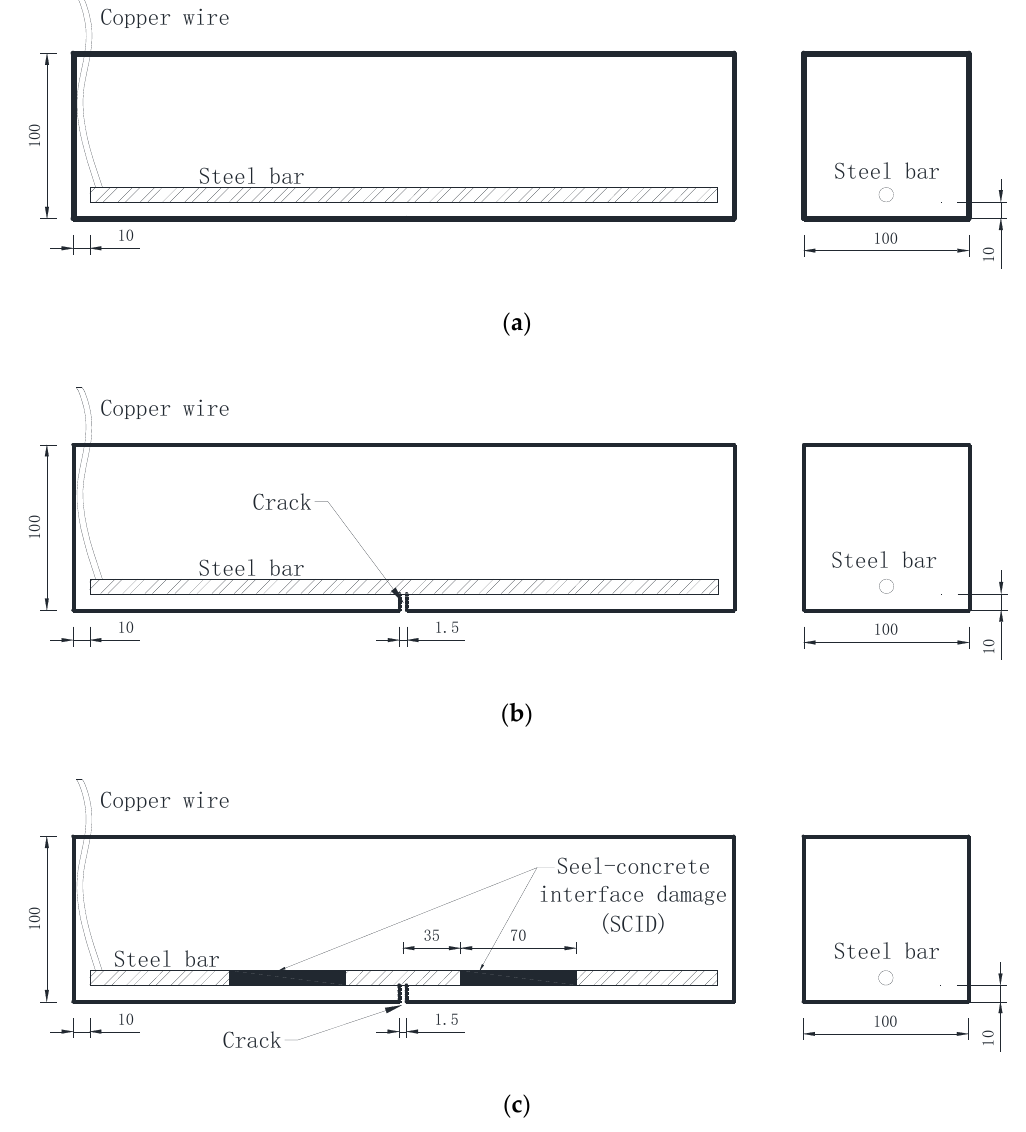
Figure 4. Schematic diagram of front and side views of specimen: ( a ) RPC and BFRPC; ( b ) RPC-C and BFRPC-C; ( c ) RPC-C-SCID and BFRPC-C-SCID.